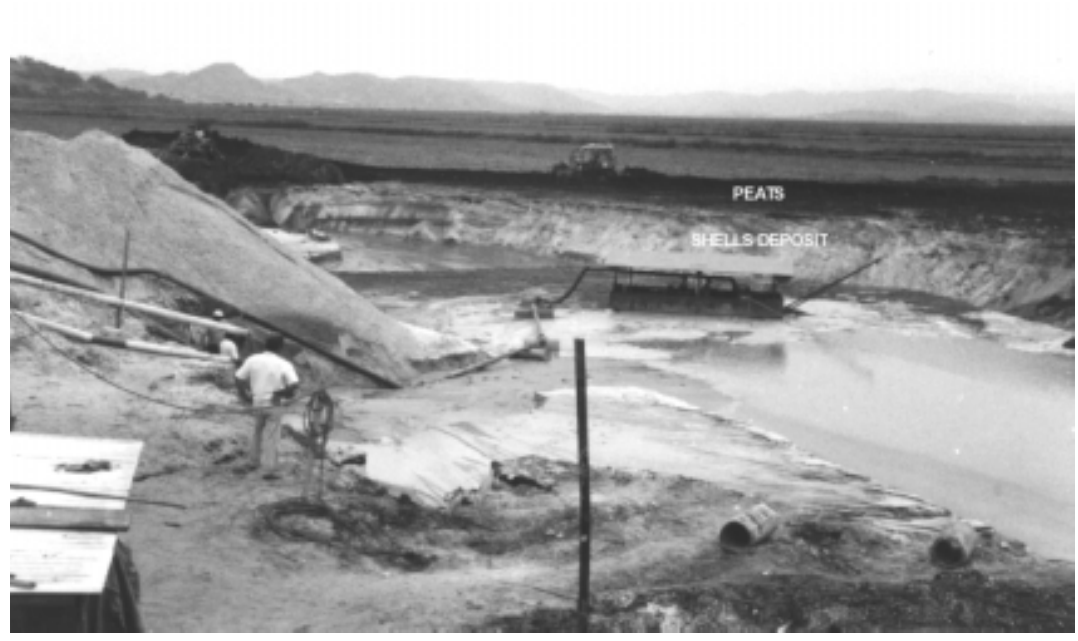
Fig. 11 – Exploitation of the calcareous shell bed of Jaboticabeira, near Jaguaruna